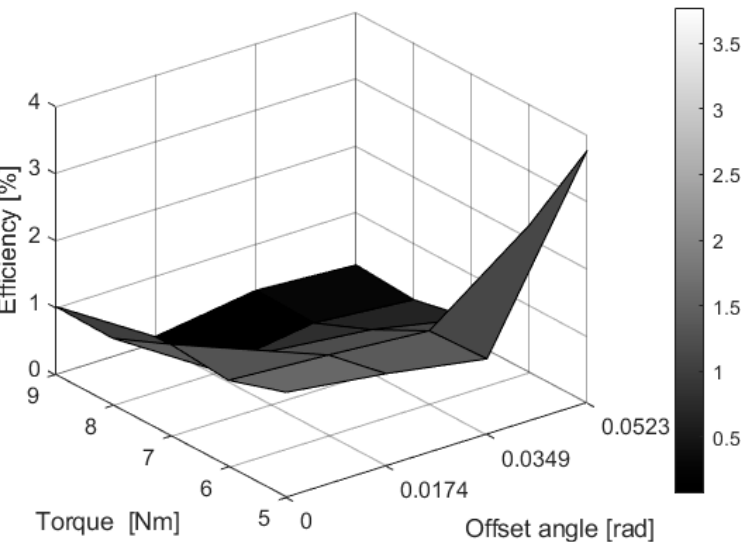
Figure 12. The di ff erence between theoretical and experimental Figure 12. The difference between theoretical and experimental results. Figure 12. The difference between theoretical and experimental results.